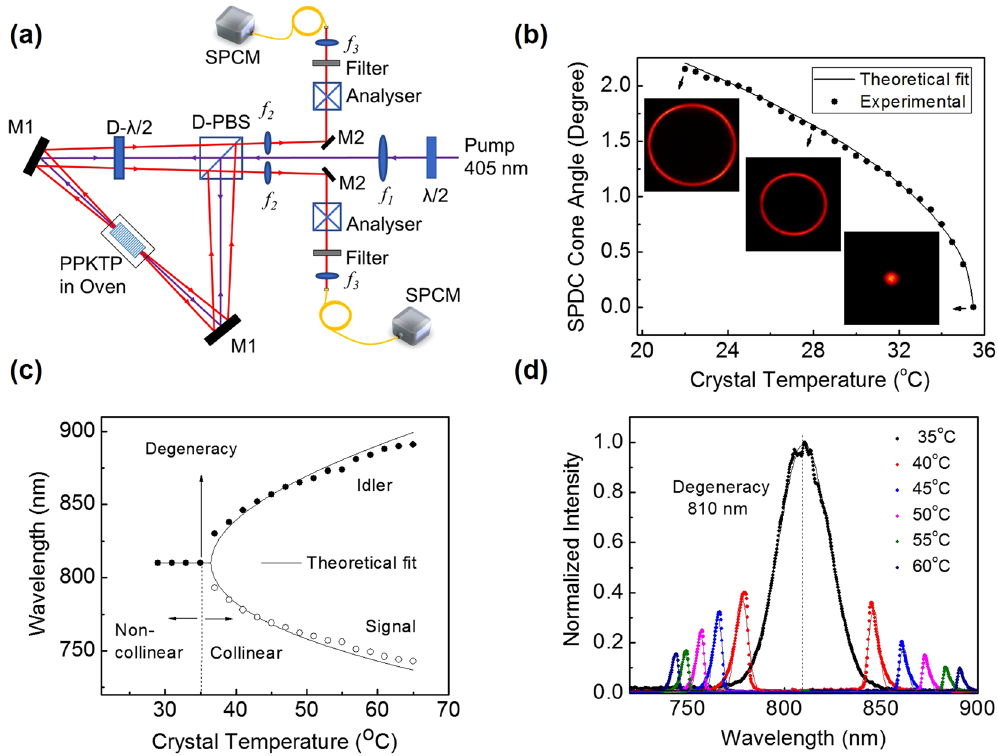
Figure 1. Bright entangled photon source based on degenerate, non-collinear, type-0 phase matching in PPKTP crystal. ( a ) Schematic of the experimental setup. λ /2, half-wave plate at 405 nm; D-PBS, D- λ /2: polarizing beam splitter cube and half-wave plate at dual wavelengths, 405 nm and 810 nm; M1-2, mirrors; f 1-3, lenses; PPKTP, nonlinear crystal in a temperature oven; Analyzer, polarization analyzer comprises a PBS and a λ /2 plate; IF, interference filter; SPCM, single photon counting module. ( b ) Variation of emission half- cone angle of the SPDC photons measured in free space with crystal temperature. Solid line corresponds to the theoretical fit to the experimental data. (Inset) CCD images of the SPDC ring at three crystal temperatures, 22 °C, 28 °C, and 35 °C. ( c ) Wavelength tuning of the SPDC photons as a function of crystal temperature. ( d ) Emission spectra of the SPDC photons recorded at different crystal